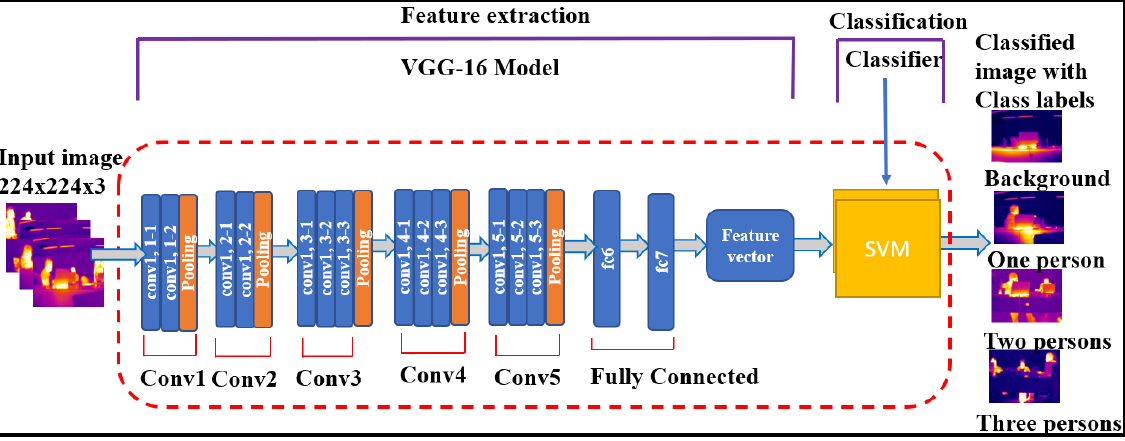
Figure 6. VGG-16 with SVM.